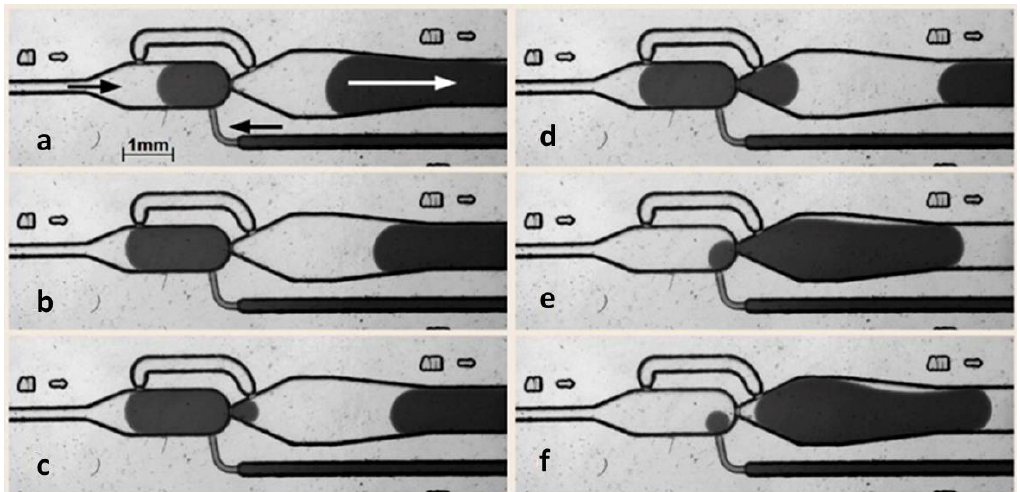
Figure 3. Image series of the self-controlled droplet-formation mode (Figure 2A). The sequence for a repetitive droplet formation goes through the following steps: ( a ) filling of the main chamber, ( b ) sealing of bypass-inlet-junction by the droplets interface, ( c ) breakthrough at the main channel nozzle, ( d ) sealing of bypass-outlet-junction by the droplets interface, ( e ) cast out of droplet with no inflow in the smallest nozzle of bypass-outlet, ( f ) cutting off the droplets at the main chamber nozzle and restarting the sequence. In this operation mode no electrocoalescence is required (details see text).